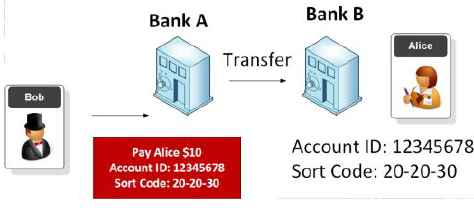
Fig. 1. Traditional banking